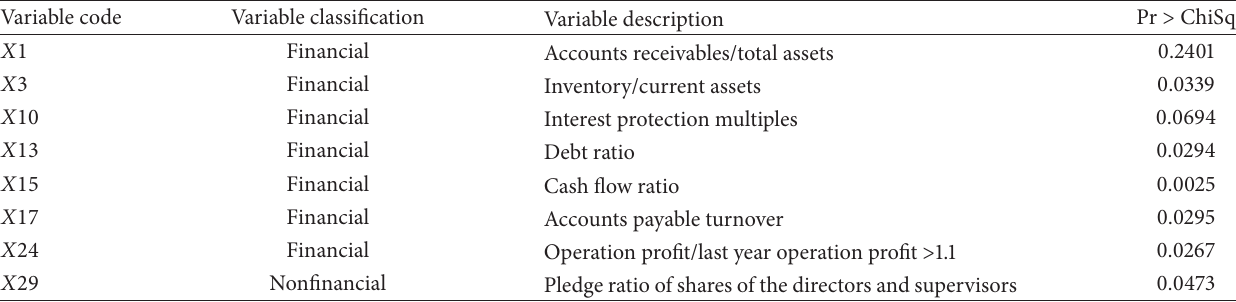
Table 1: Results of stepwise regression variable screening.